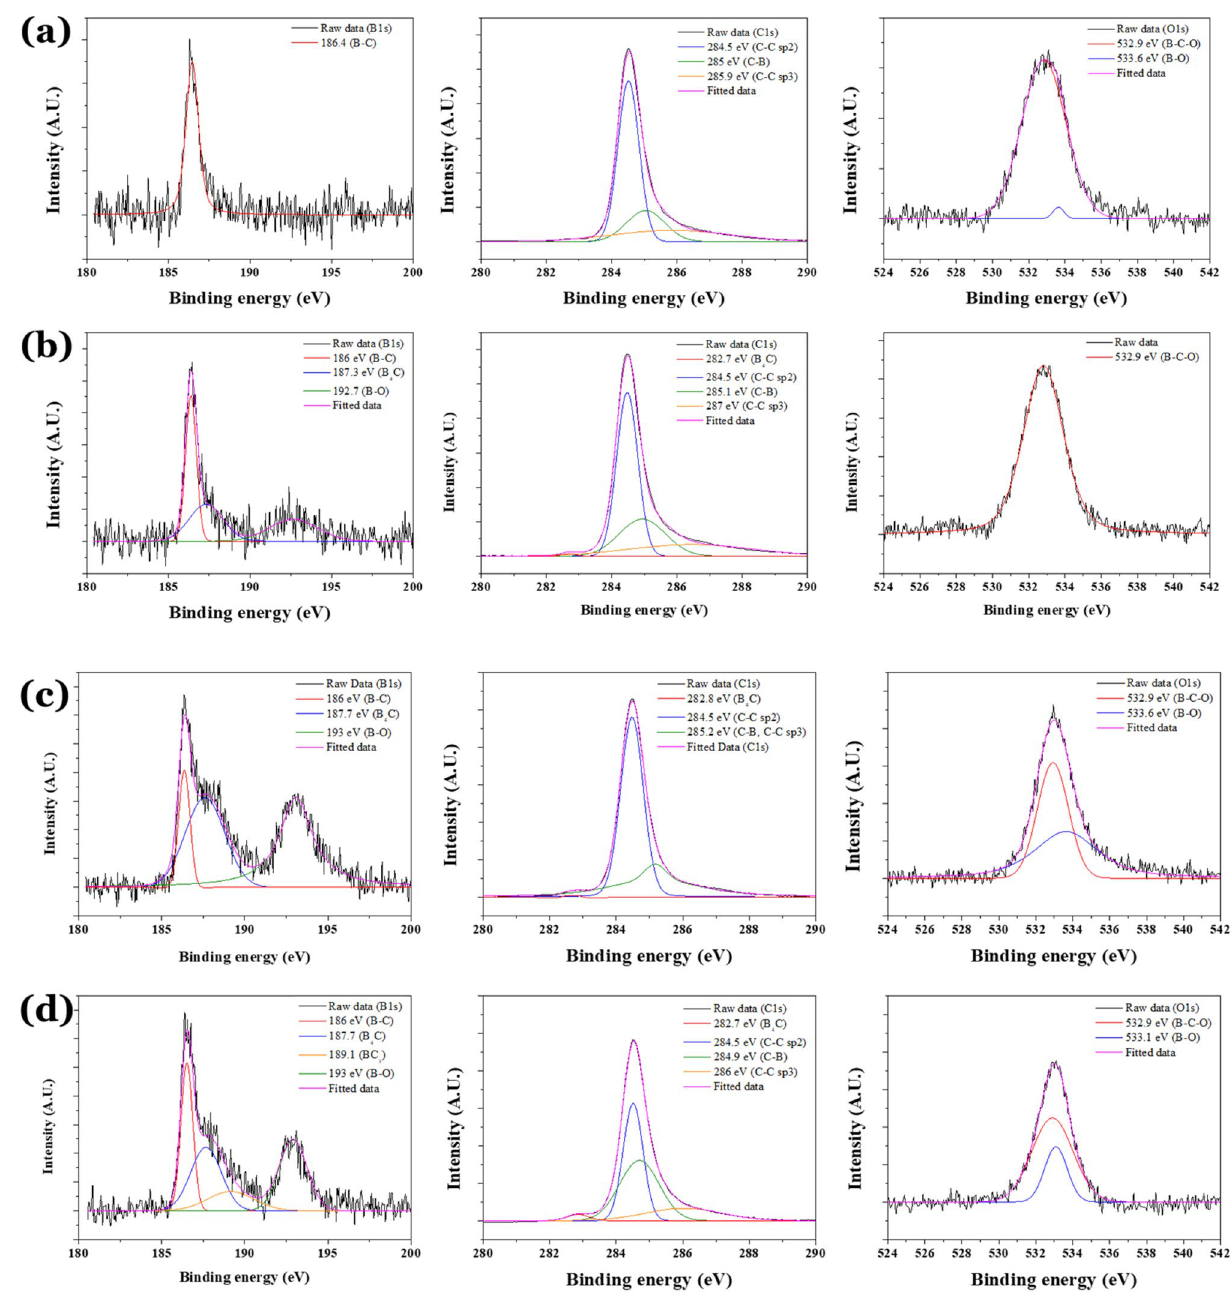
Fig. 7 XPS pattern of boron-doped SG: a 4203-B1-2500, b 4203-B3-2500, c 4203-B5-2500, and d